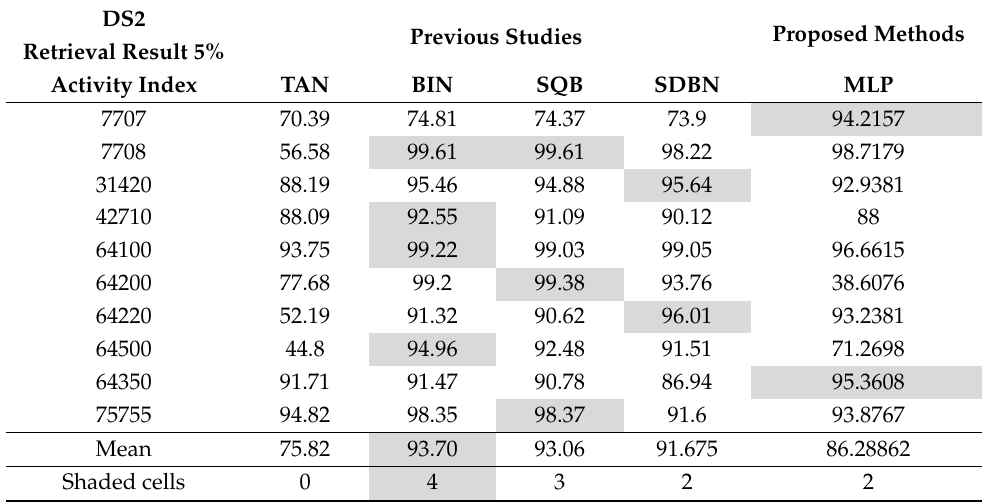
Table 9. Top 5% retrieval results for MDDR-DS2 dataset for descriptor (ECFC 4).